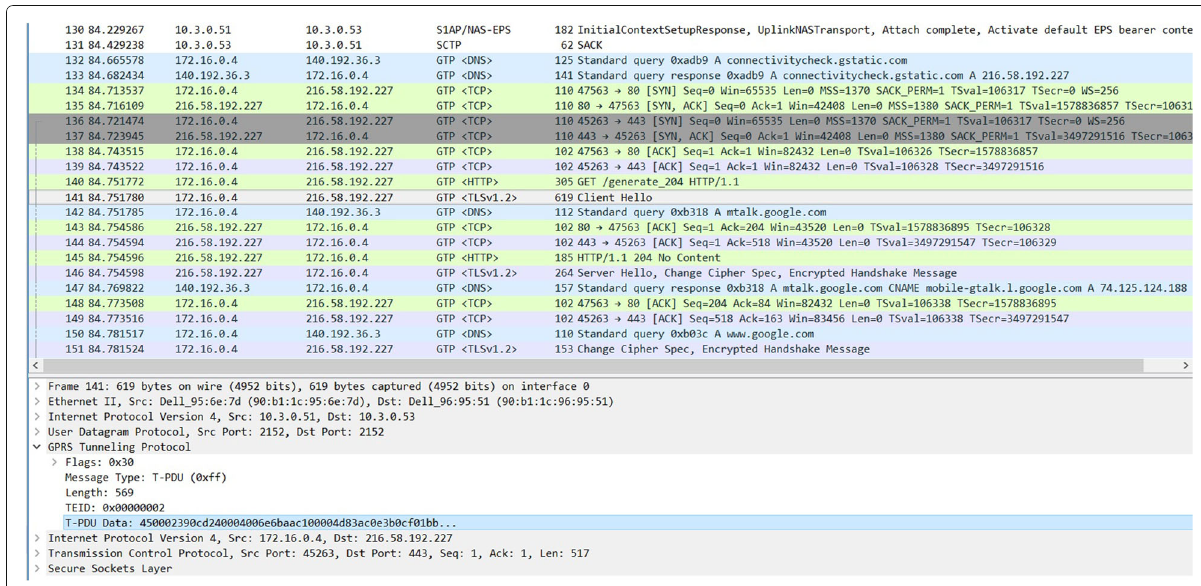
Fig. 5 A CC record for an LTE DNS and HTTPS user session. The capture is taken from a test LTE network setup using the OAI open-source LTE implementation